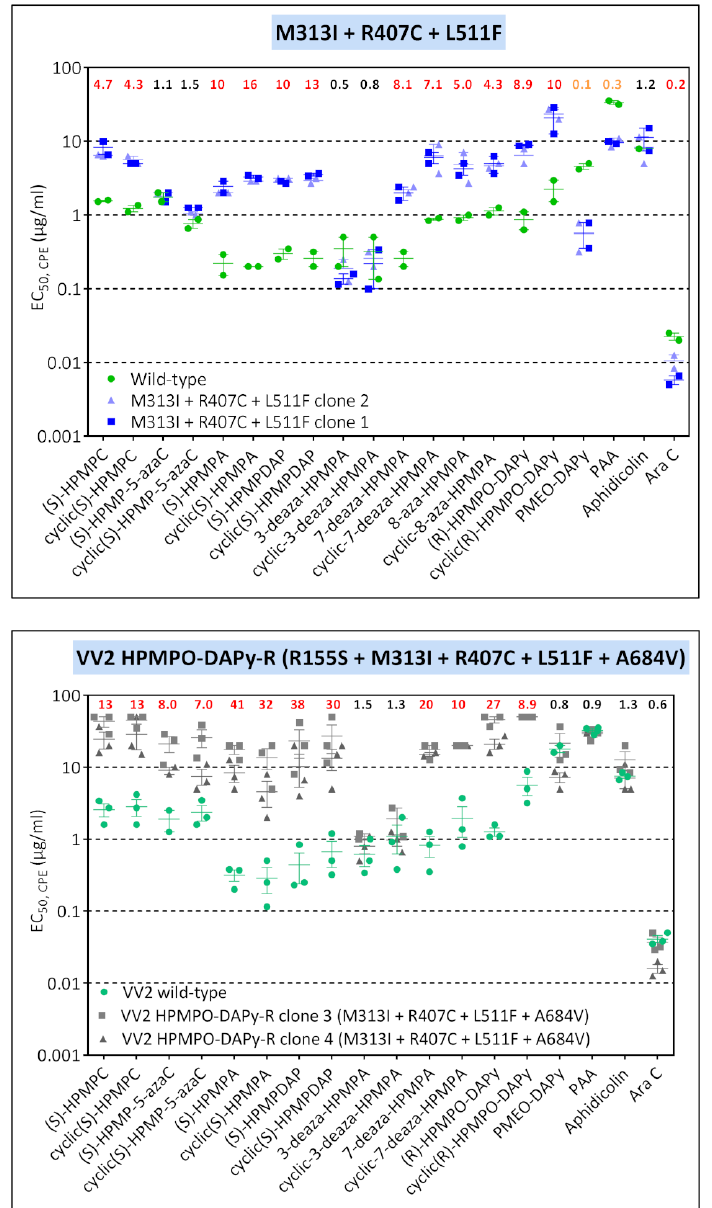
Figure 8. Drug-susceptibility profile of selected VV2 HPMPO-DAPy-R viral clones to evaluate the impact of the M313I, R407C, L511F, and A613T DNA polymerase substitutions. The source of the viral clones was as follows: R407C + L511F (VV2 HPMPO-DAPy-R #5), M313I + R407C + L511F (VV2 HPMPO-DAPy-R #10), and R155S + M313I + R407C + L511F + A684V (VV2 HPMPO-DAPy-R #31). Drug-resistance properties of the different types of viral clones were determined using a CPE reduction assay with HEL fibroblasts. The effects of different drugs on viruses encoding the indicated mutations were determined by calculating the EC50 values for the parental wild-type strain and clones bearing the specific mutations. At least two independent experiments were performed for each test compound. Horizontal lines for each drug and mutant viral clones indicate the mean values ± standard deviation. The fold resistance (ratio of the EC50 for the mutant viruses to the EC50 for the wild-type VV2 is marked at the top of the graph. VACV viral clones showing a ≥ 2-fold increase (red, bold) were considered drug resistant (R) and those with a ≤ 0.5-fold decrease (orange, bold) drug hypersensitive